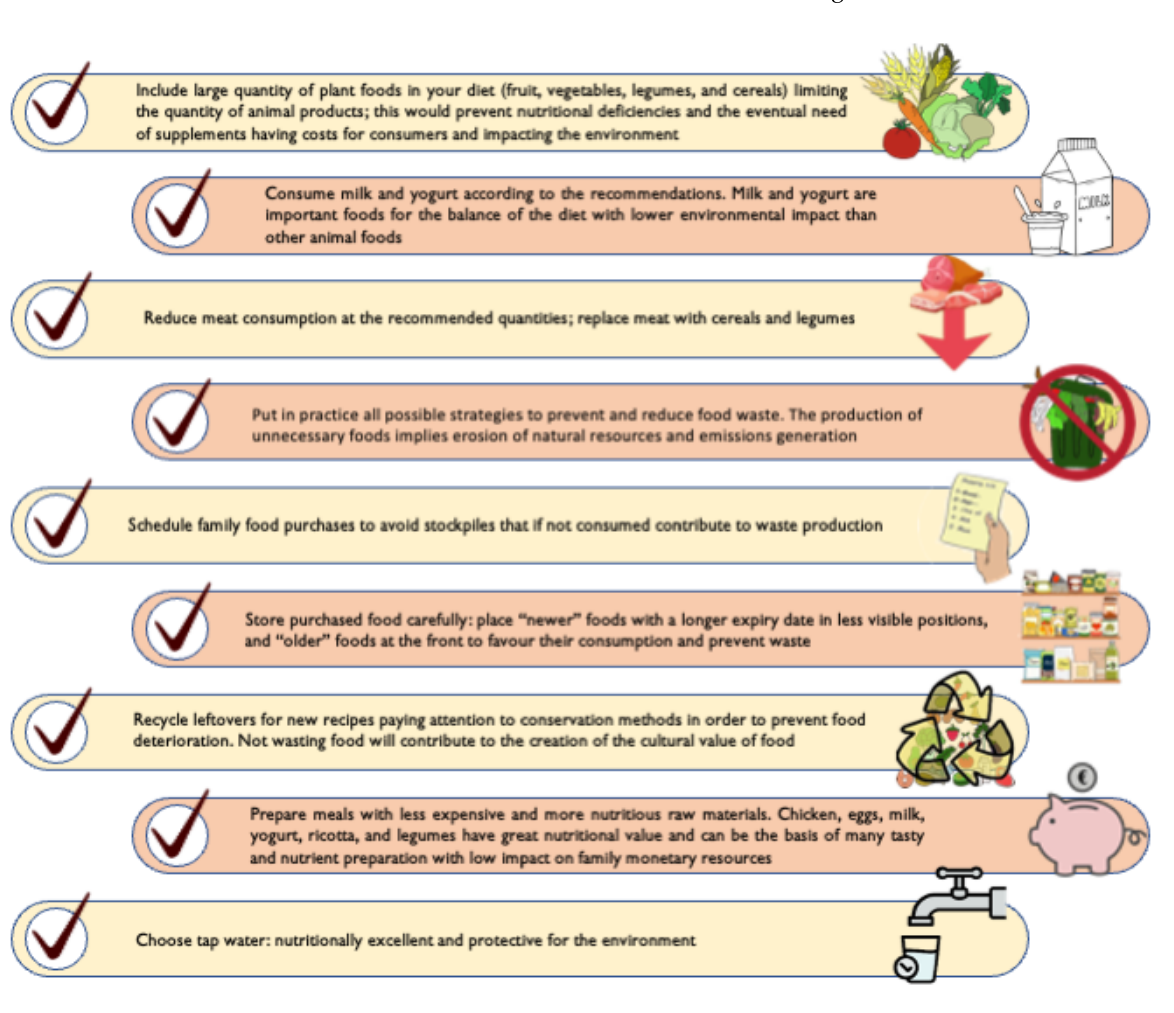
Figure 2. Key recommendations (How to…) from the IDGs’ sustainability chapter–directive 13.